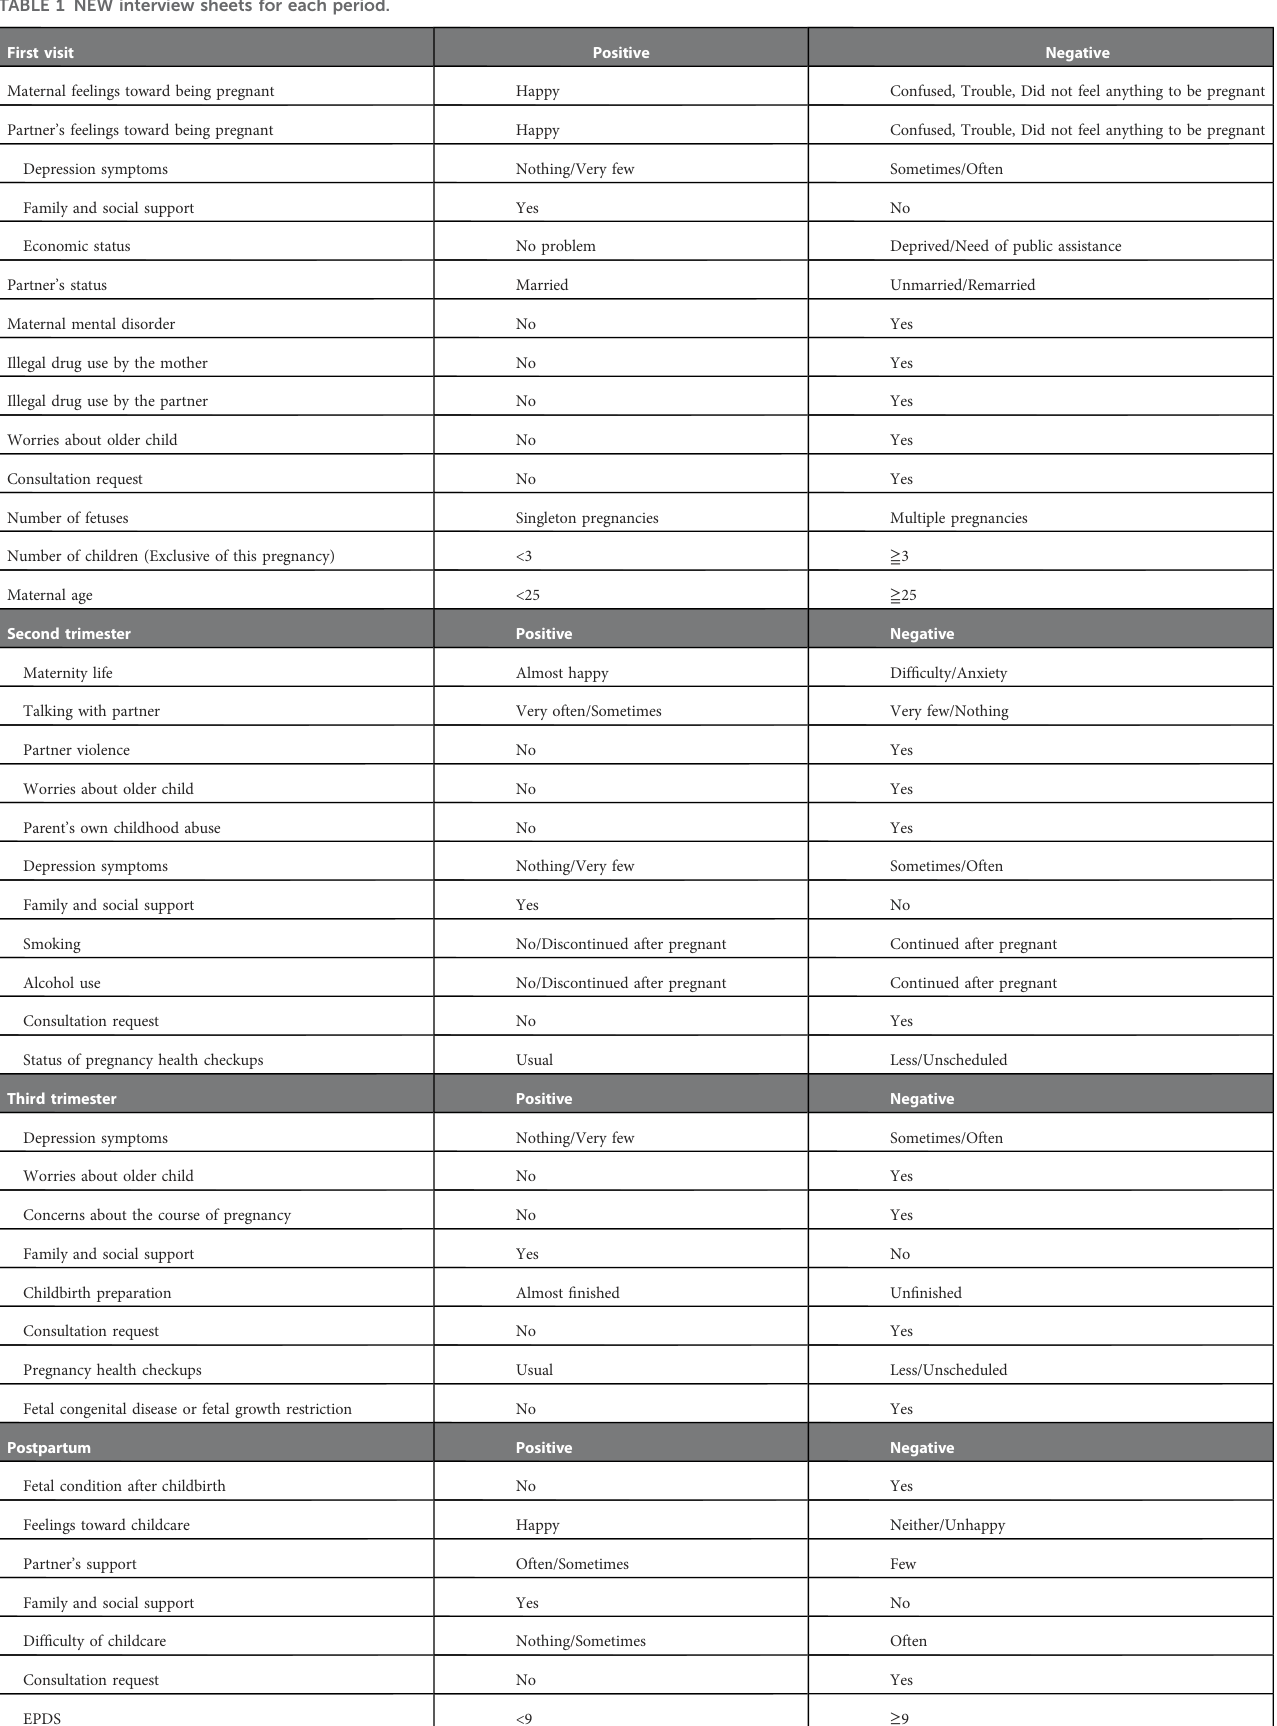
TABLE 1 NEW interview sheets for each